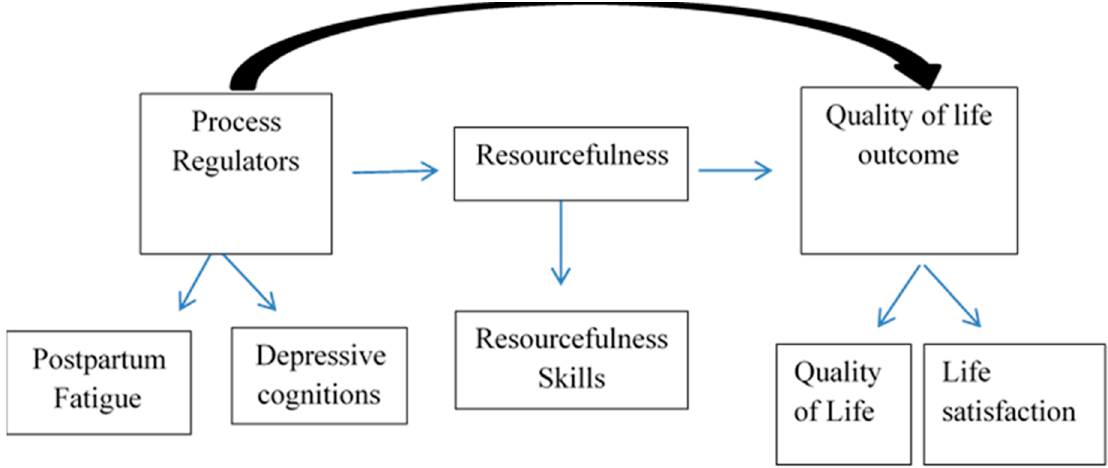
Figure 1. Research model for study of postpartum Arabic women.